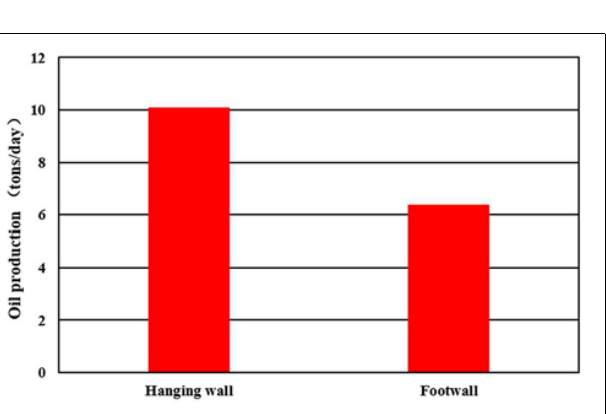
FIGURE 12 | The oil production in the wells located at hanging wall and foot wall of fault.